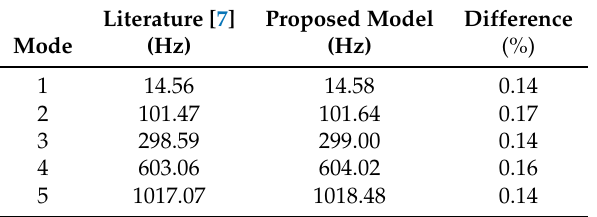
= 0.2) (Case 2). m beam